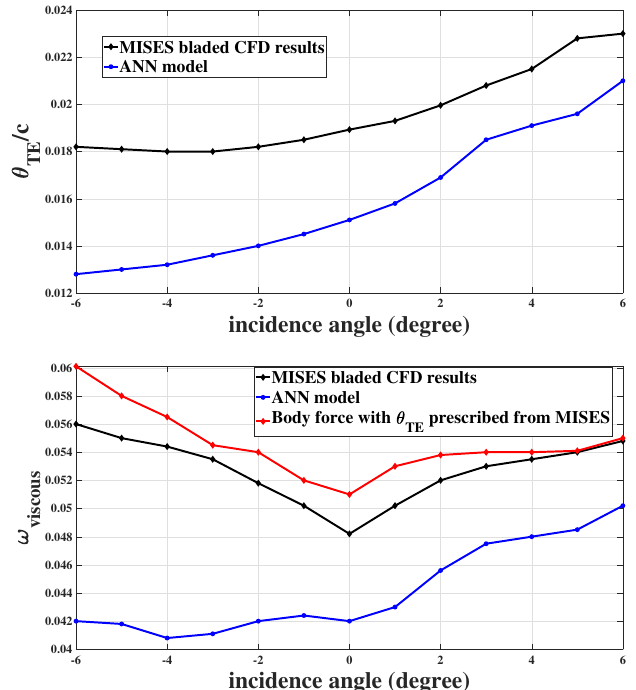
Figure 9. Comparison of trailing edge momentum thickness ( top ) and loss coefficient ( bottom ) from MISES and ANN model for cascade 3 ( σ = 2.0, M ∞ = 0.4, Re = 4.4 × 10 5 ).